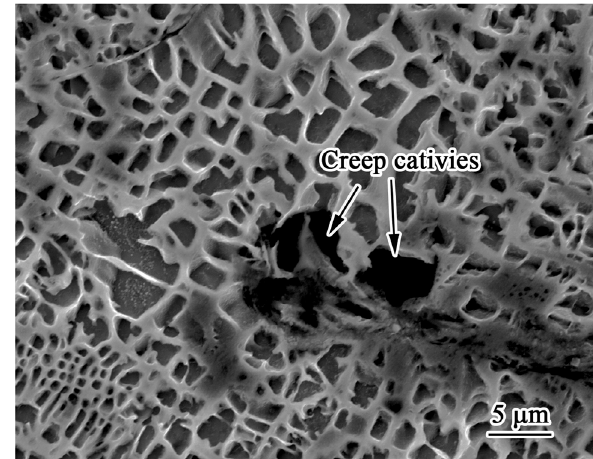
Figure 4: Creep cavities after a long-term